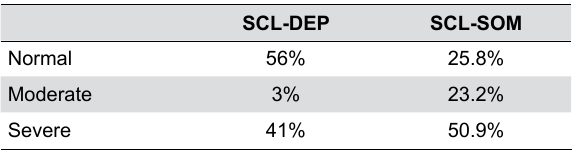
Table 2- Percentage of patients receiving different scores in the Research Diagnostic Criteria for Temporomandibular Disorders (RDC/TMD) Axis II Depression (SCL-DEP) and Somatization (SCL-SOM) scales